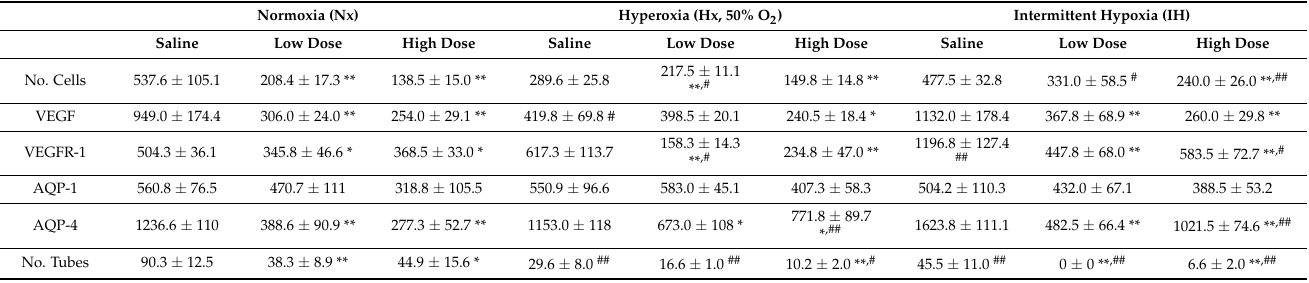
Figure 4. Representative images of the effect of bumetanide on VEGF-A immunoreactivity (green) counterstained with DAPI (blue) in cultured human microvascular retinal endothelial cells (HMRECs) exposed to normoxia (Nx), hyperoxia (Hx, 50% O 2 ), or intermittent hypoxia (IH) for 72 h. Images were captured at 20 × magnification (scale bar is 50 µ m). Quantitative analysis of VEGF immunoreactivity is presented in Table 1.